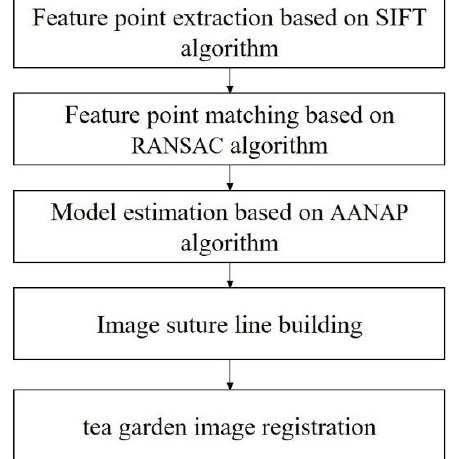
Figure 3. Flowchart of the image registration.